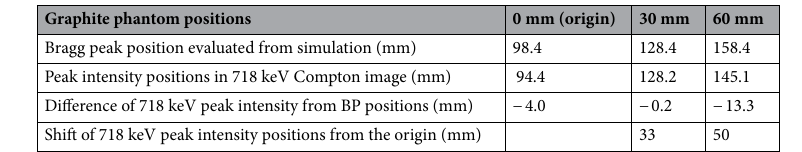
Table 1. Numerical table illustrating Bragg peak (BP) position evaluated using Monte Carlo simulation, position of peak intensity of 718 keV Compton image, difference of 718 keV peak intensity from BP positions, and the shift of 718 keV peak intensity positions from the origin for the graphite phantom positioned at 30 mm and 60 mm.